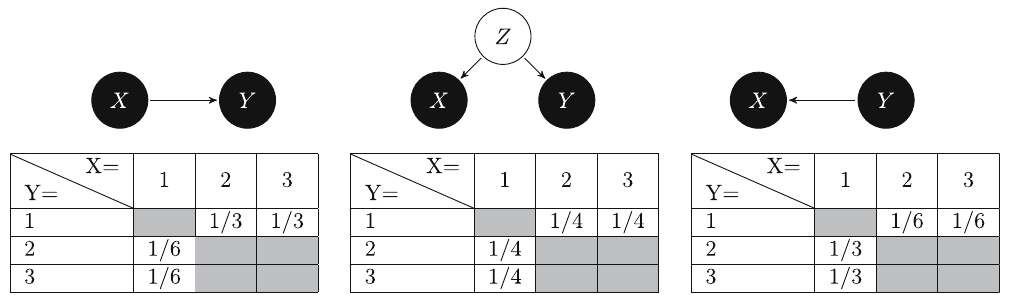
Figure 2: Left: Joint probabilities when the ball enters from the top ( X is the cause ) . Middle: probabilities when the ball enters from the sky ( common cause ) . Right: when the ball enters from the bottom ( Y is the cause ) .